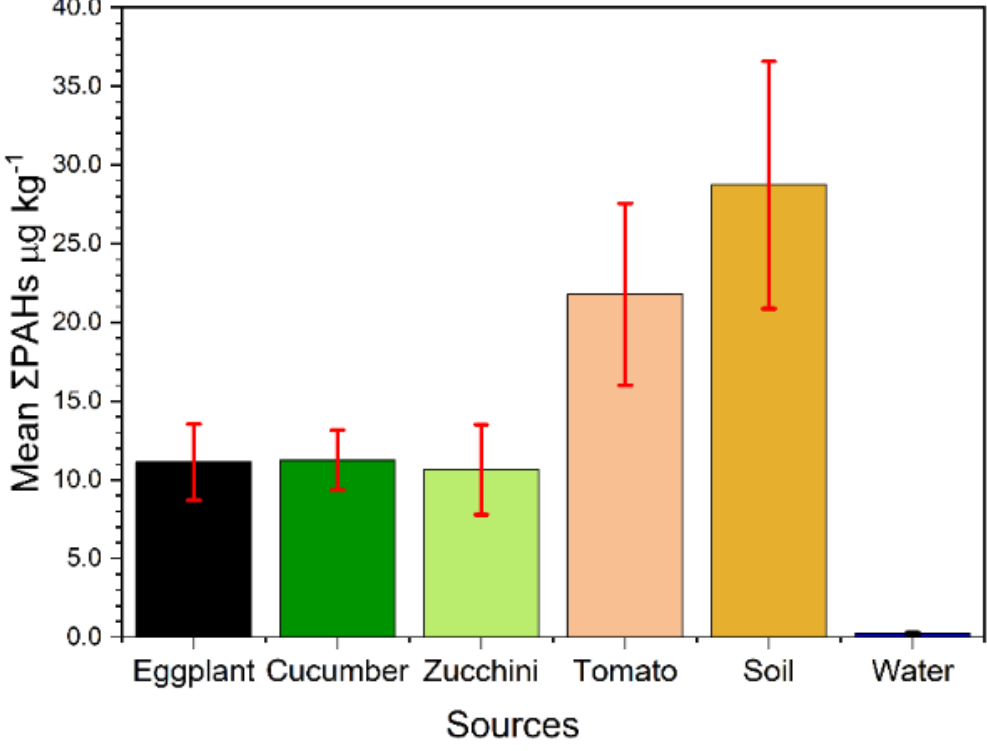
Figure 3. Mean ∑16PAHs in each type of plant, soil, and water samples from the studied area. Figure 3. Mean ∑ 16PAHs in each type of plant, soil, and water samples from the studied